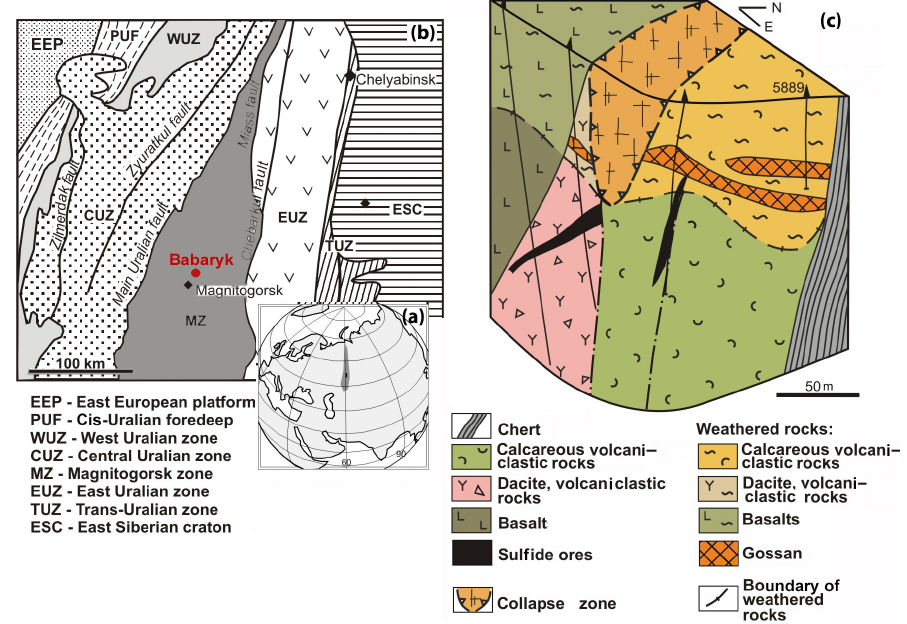
Figure 1. Geographical (a) and geodynamic (b) setting (after Kozlov, 2001) and geological block diagram (c) of the Babaryk VHMS occurrence. Borehole no. 5889 is